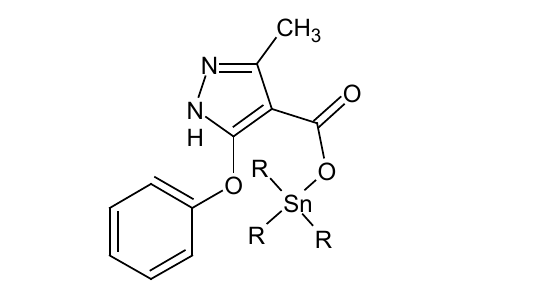
Figure 5. Struture of the triphenyltin(IV) pyrazolecarboxylate.